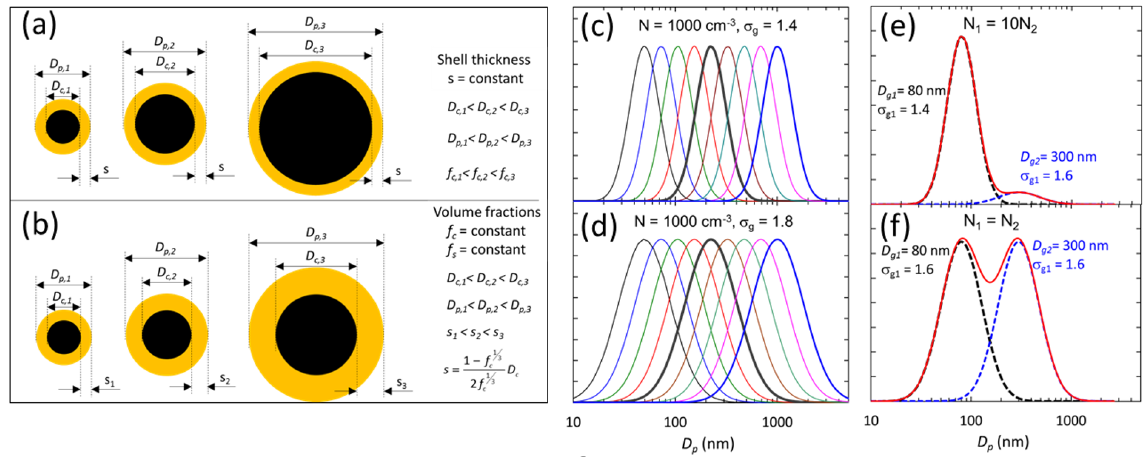
Figure 1. Examples of particles and size distributions used in the simulations: (a) particles with a BC core coated with a constant shell thickness s , (b) particles with constant BC core and shell volume fractions f c and f s , (c) unimodal narrow size distributions with the geometric standard deviation of σ g = 1.4, (d) unimodal wide size distributions with σ g = 1.8, (e) bimodal size distributions with a dominating Aitken mode, and (f) bimodal size distributions with equal-sized Aitken and accumulation